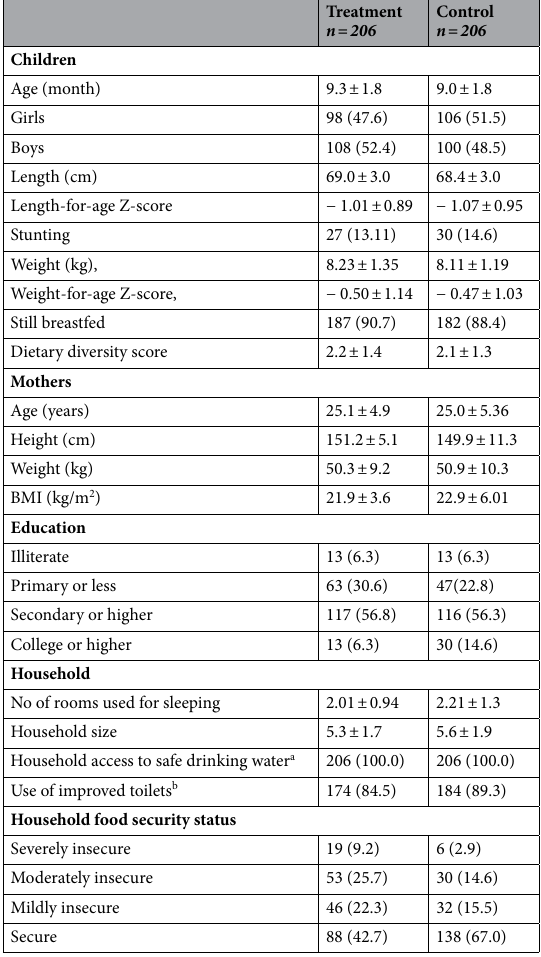
Table 1. Characteristics of the households and mother–child pairs in the treatment and control groups at enrolment. Values are presented as n (%) or mean ± SD. a Safe drinking water: Sources by the nature of their construction that adequately protect water from outside contamination, in particular fecal matter. b Improved toilet: sanitation facilities that hygienically separate human excreta from human contact.